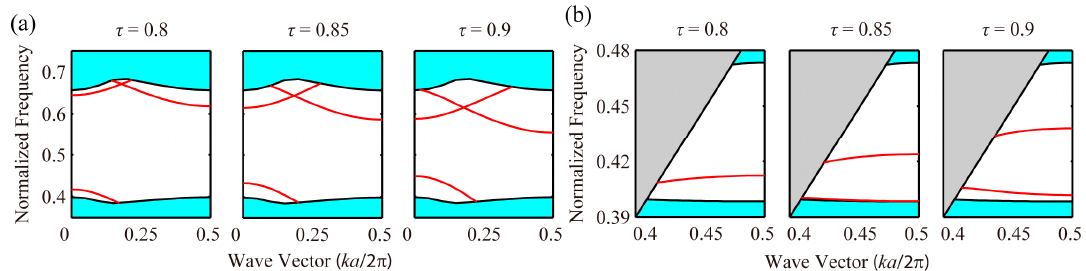
Figure 12. Dispersion curves of the surface wave bands of phononic ( a ) and photonic odd ( b ) modes for different τ , where τ increases from 0.8 to 0.9 with a step of 0.05. The cyan and gray areas represent the projected bulk modes and light cone, respectively.